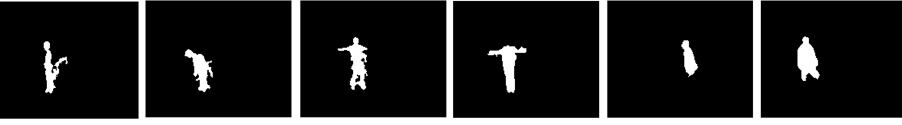
Figure 3. Examples depicting various artefacts resulting from the background